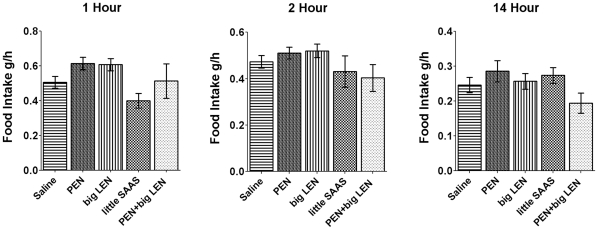
Comparison of food intake in mice injected with proSAAS-derived peptides.Mice do not show a significant peptide-induced change in food intake measured 1 hour, 2 hours, or 14 hours after the injection of either saline or the proSAAS-derived peptides: PEN, big LEN, little SAAS, or a combination of PEN and big LEN. Altogether 18 mice were cannulated and after recovery from surgery, injected with either 10 µg of peptide in saline or with saline alone. After 3–7 days of recovery, the mice were re-tested with the saline and peptide groups switched so that over the course of the study, each mouse received at least one control saline injection and injection of at least one of the different peptides. Error bars show standard error of the mean for saline (n = 37); PEN (n = 15); big LEN (n = 15); little SAAS (n = 8); and the combination of PEN and big LEN (n = 16).